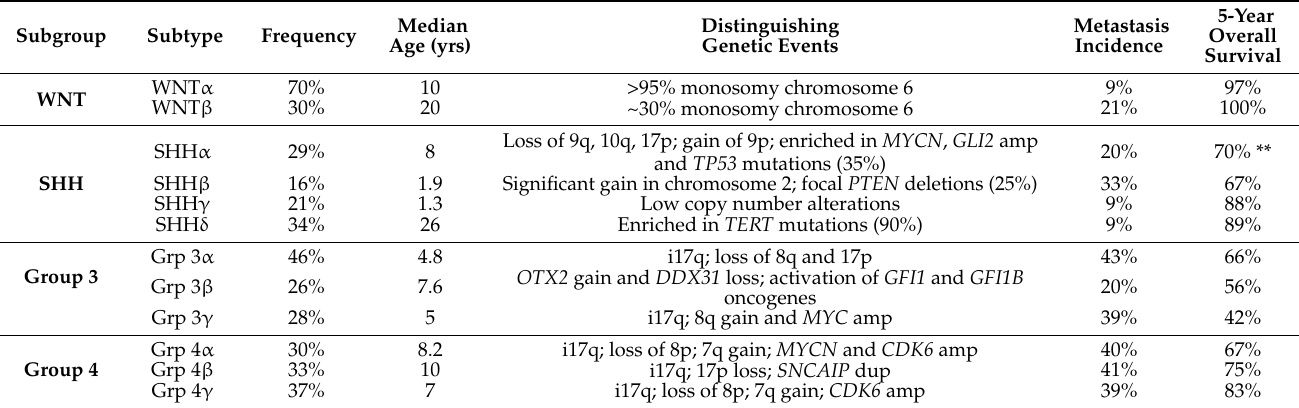
Table 1. Tumor subtypes within medulloblastoma subgroups